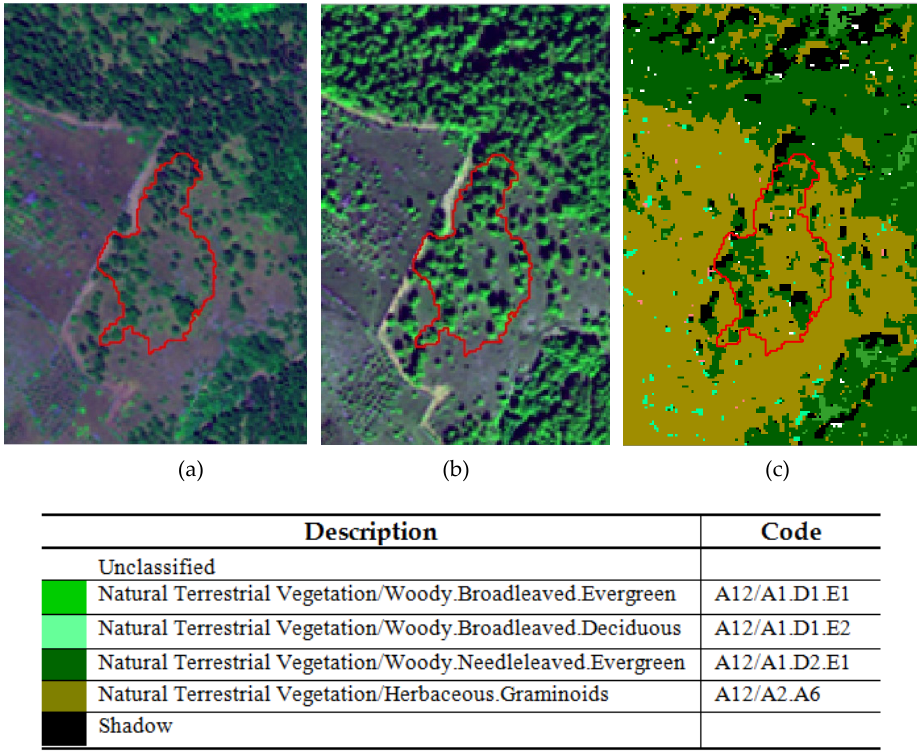
Figure 11. A close-up of an area of Murgia Alta. ( a ) DS image, ( b ) PostPoB image, ( c ) SO map. In the red line the LO considered.